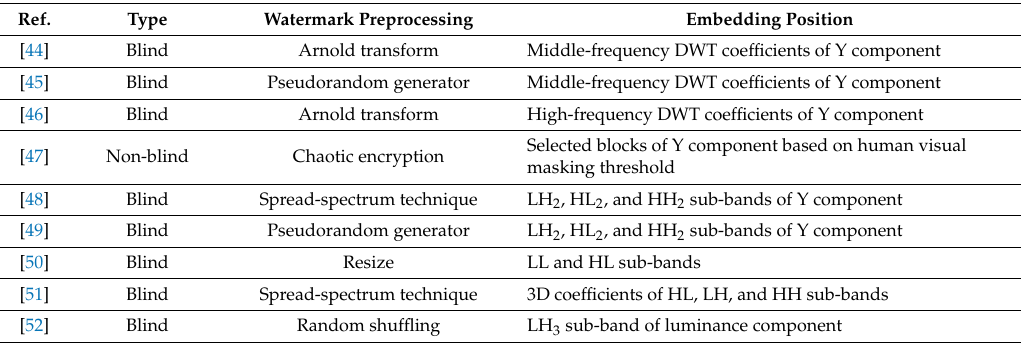
Table 4. Summary comparison of several watermarking algorithms in DWT